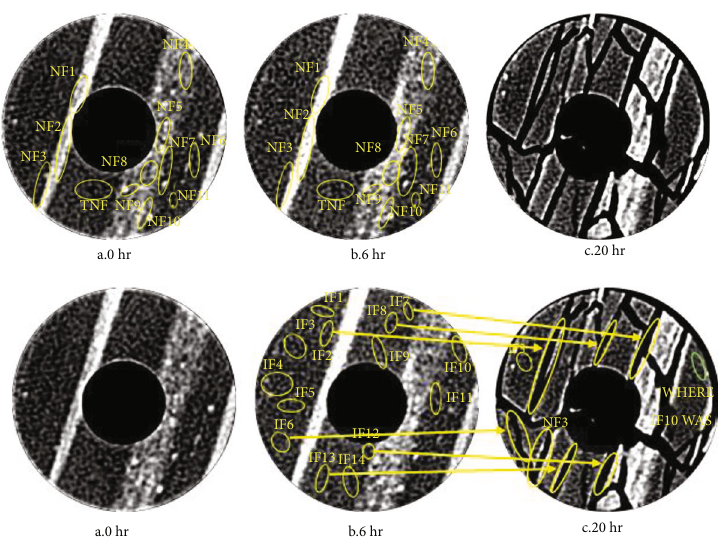
Figure 13: Results for EF-6. The testing condition was 1350 psi axial and 500 psi con fi ning pressure